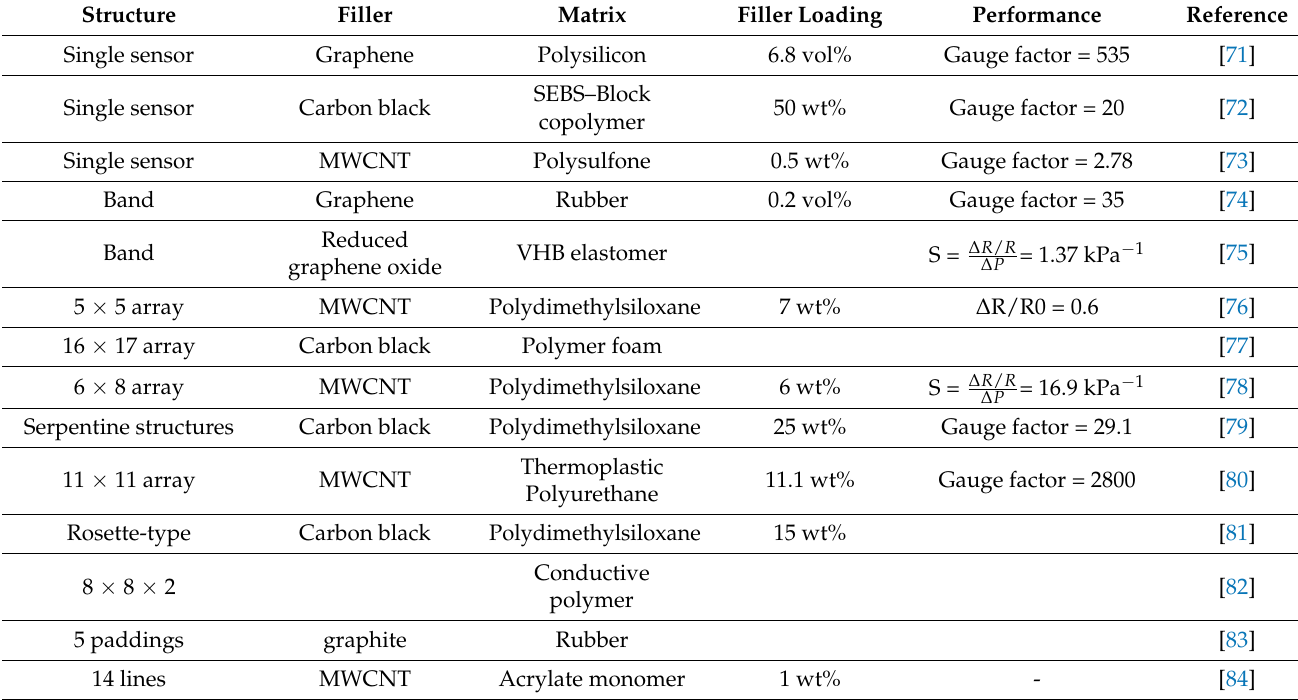
Table 6. Several tactile sensing systems.